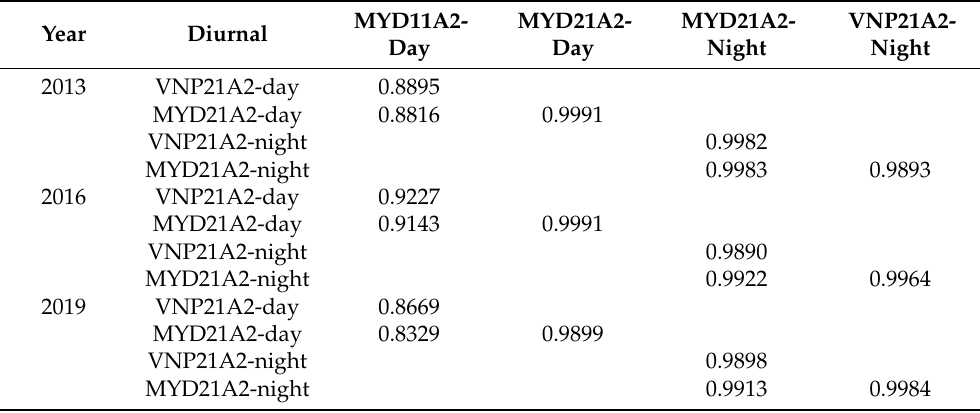
Table 3. Correlation between the three Kimberley LST products (day and night).